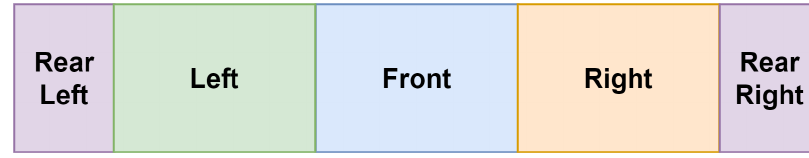
Figure 3. Normal stitching technique.